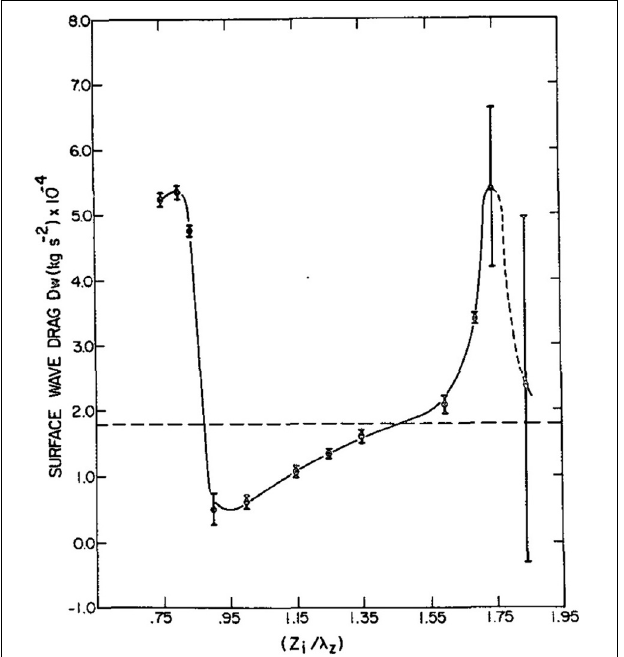
FIGURE 8 | Drag obtained from numerical simulations as a function of z c /λ z (denoted here by z i /λ z ). Reproduced from Figure 5 of Clark and Peltier [73]. © American Meteorological Society. Used with